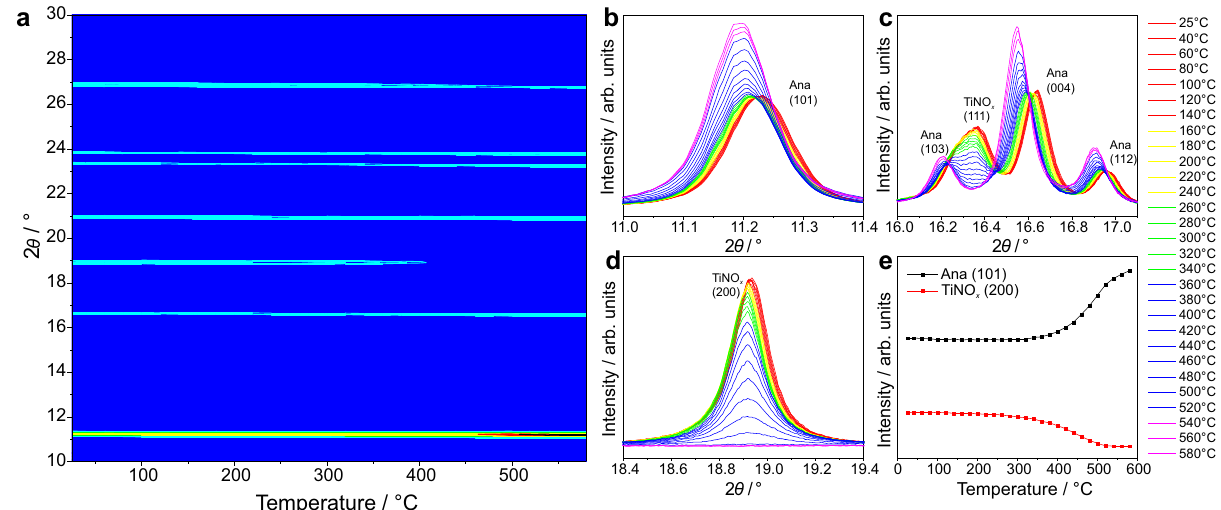
Fig. 8 Crystallographic variable temperature analysis of A4. a In-situ VT-SXPD patterns; ( b – d ) enlarged regions showing the decomposition of TiNO x and increase in anatase intensity; ( e ) intensity of anatase (101) and TiN (200) plotted against temperature (negligible standard deviation not plotted).